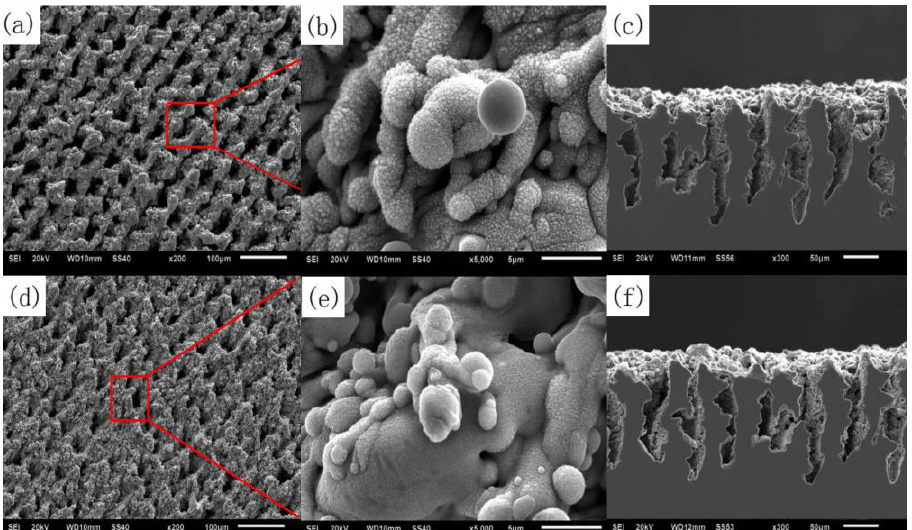
Figure 29. SEM images of laser treated carbon steel before and after coating with PHPS: ( a ) surface microstructure before coating with PHPS; ( b ) surface nanostructure before coating with PHPS; ( c ) cross-sectional morphology before coating with PHPS; ( d ) surface microstructure after coating with PHPS; ( e ) surface nanostructure after coating with PHPS; ( f ) cross-sectional morphology after coating with PHPS. (The red box and line represent the image of the selected area) (Reprinted with permission from Ref. [105]. 2018, Song, J.J.).